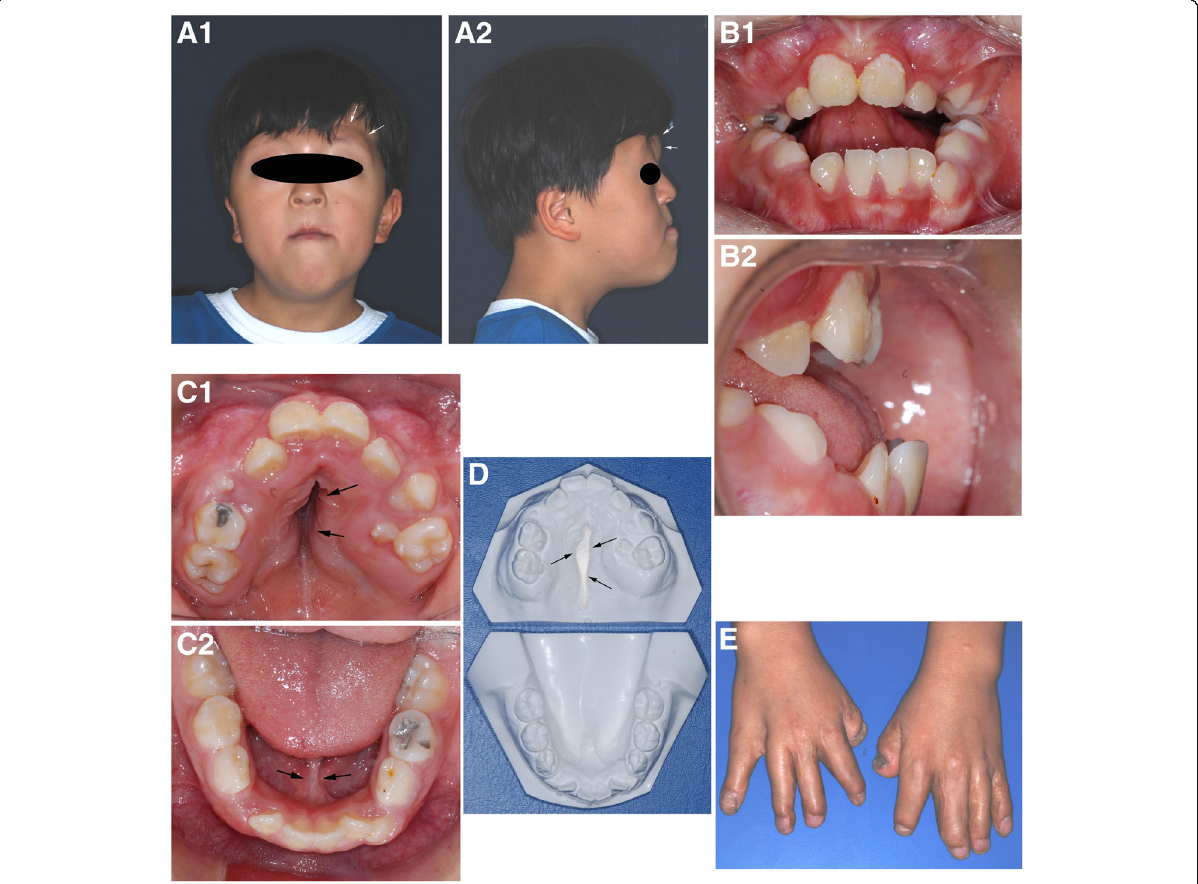
Fig. 1 Photograph of an Apert syndrome patient, a 9-year-old male. Facial profile: frontal view ( A1 ): hypertelorism, turribrachycephalic cranial profile, horizontal groove above supra orbital ridge (arrows), and a short nose with bulbous tip. Lateral view ( A2 ): retarded maxilla and frontal proptosis (arrows). Intraoral view: anterior view ( B1 ): anterior open bite and poor oral hygiene. Lateral view ( B2 ): retruded maxillary incisors. Upper occlusal view ( C1 ): narrow and triangular shape maxillary arch with Byzantine arch-shaped palate. Lower occlusal view ( C2 ): almost normal U-shaped mandibular arch with thick lingual frenum (arrows). D Plaster dental model: fissure-like palatal groove (arrows). E Hand, incompletely separated and with short fingers even after syndactyly operation performed 3 years